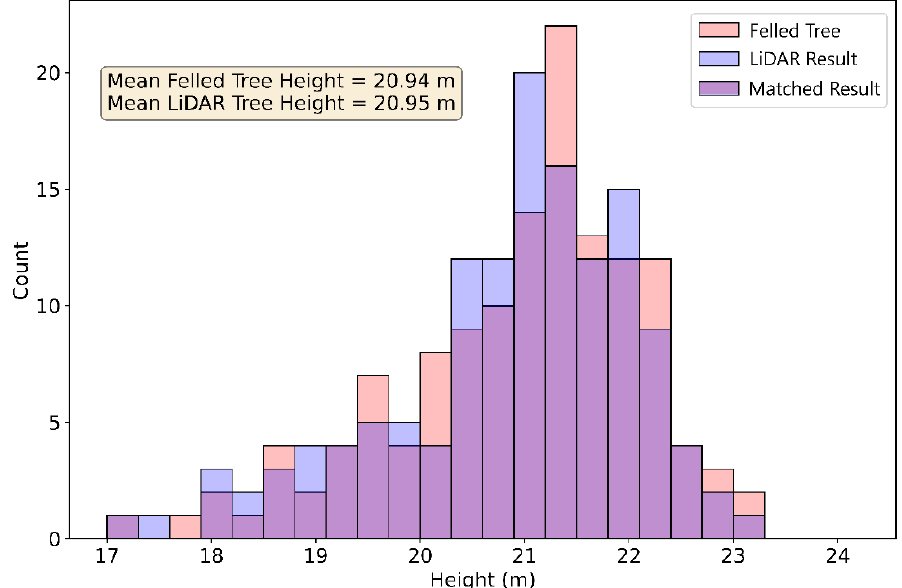
Figure 3. ForestView ® growth-adjusted tree height distribution (blue) compared to felled-tree field measured height distribution (red). The (purple) color is where these two datasets overlap, representing a “matched result”.